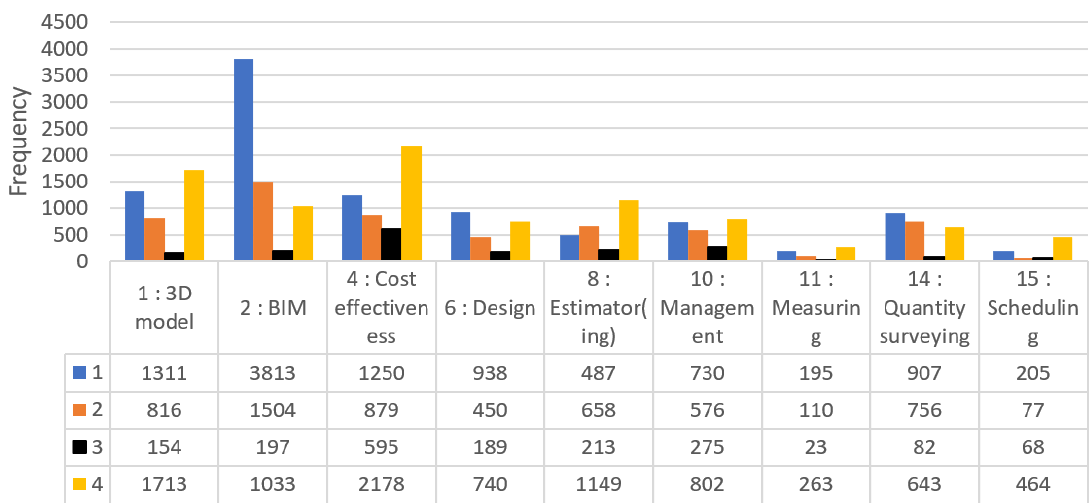
Figure 9. The trend of key themes is represented by word frequency over the years from 2010 to 2019.